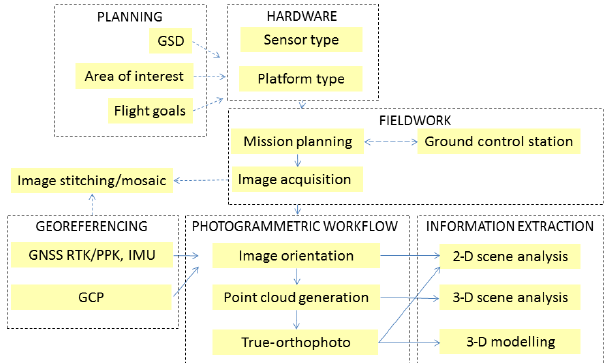
Figure 2. Acquisition and processing of RPAS images: general